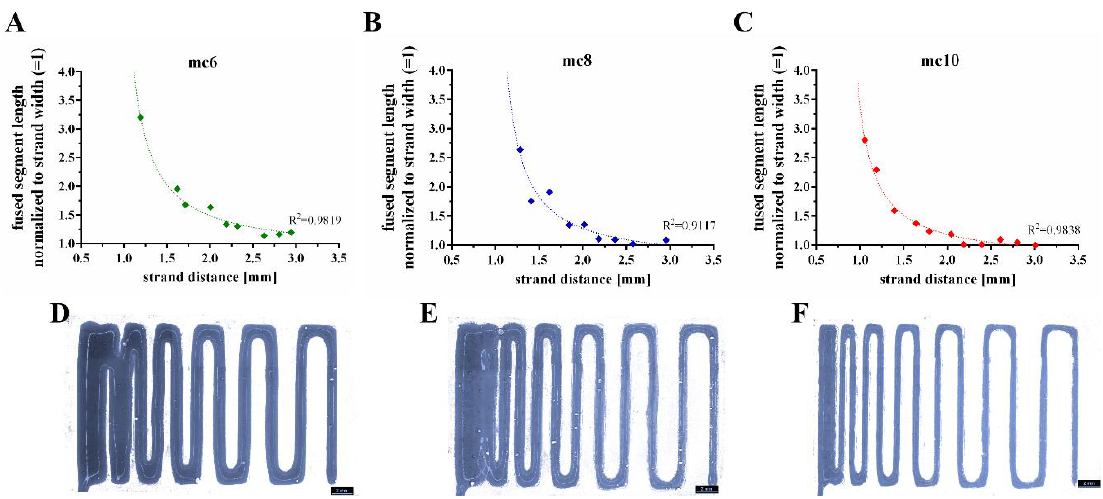
Figure 4. Representative fused filament tests of mc6 ( A , D ), mc8 ( B , E ), and mc10 ( C , F ) pastes.